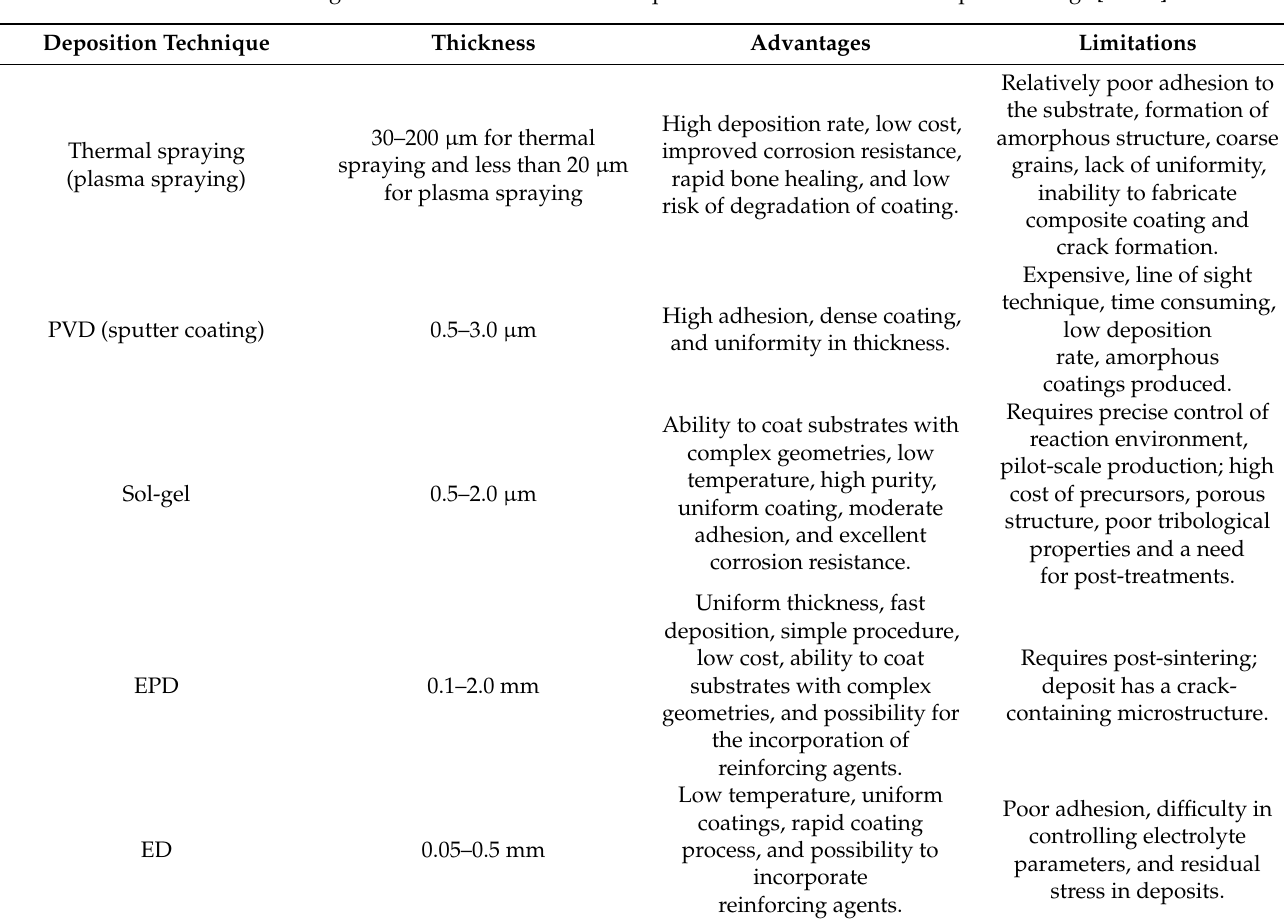
Table 2. The advantages and limitations of the techniques used for fabrication of HAp biocoatings [95–99].